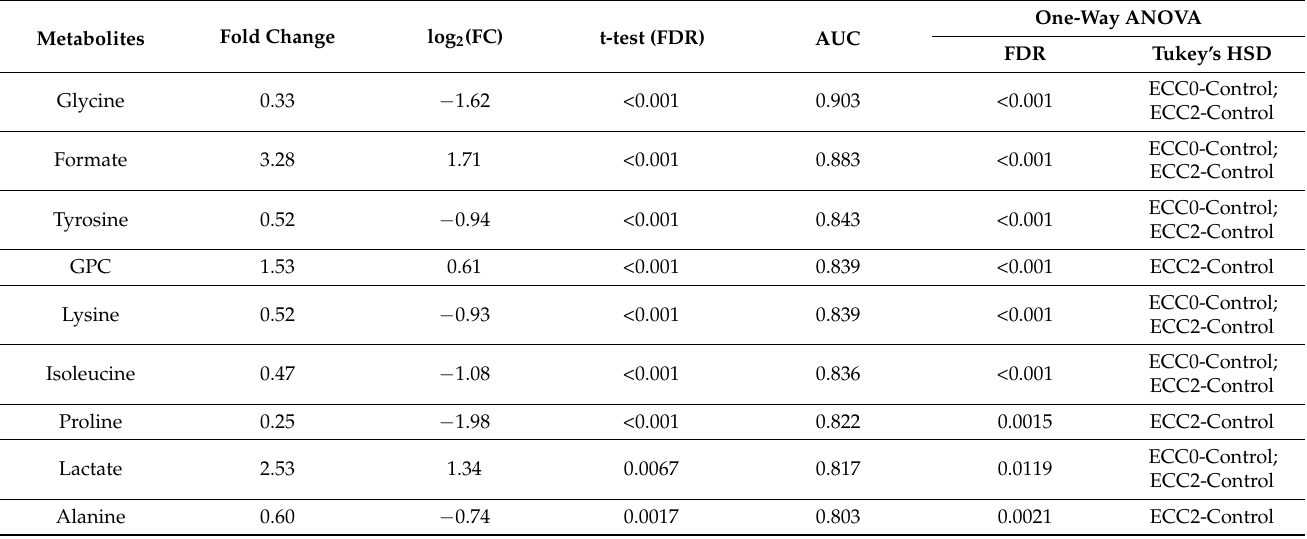
Figure 3. Multivariate ROC analysis. All ROC curves ( A ) and predictive accuracies ( B ) of five models created from nine biomarkers using different number of features. ROC curve ( C ) of model 3 generated using four features and the top significant features ( D ) predicted based on their frequencies of selection during cross-validation. Abbreviations: Var., variable; AUC, area under curve; CI, confidence interval. Table 2. Potential metabolite biomarkers for differentiating the samples from study participants with caries and a healthy